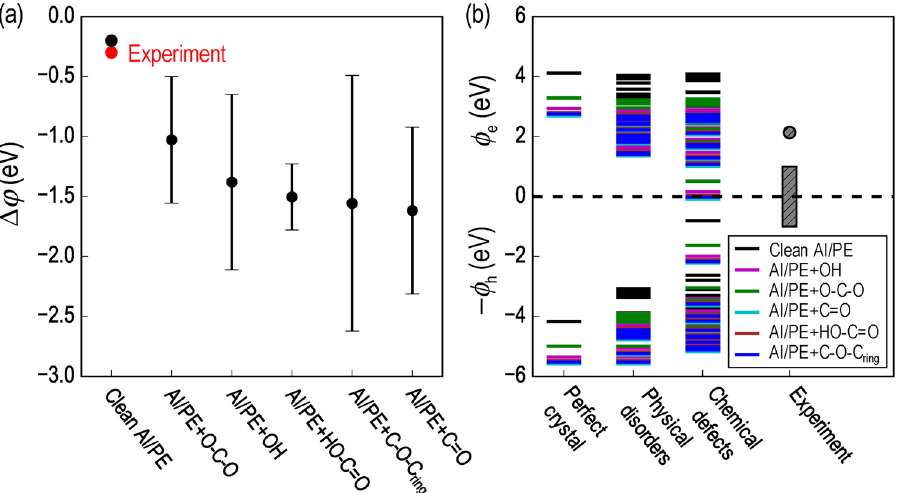
Figure 3. ( a ) Computed vacuum level shift Δ ϕ at Al/PE interfaces, of which the error bars are obtained from the standard deviations of the results from different orientations of the O-containing groups. ( b ) Electron and hole injection barrier φ e and φ h computed for the Al/PE interface, of which the PE slab may or may not contain physical disorders and/or chemical defects. Experimental values of the barriers are taken from Refs 33 and